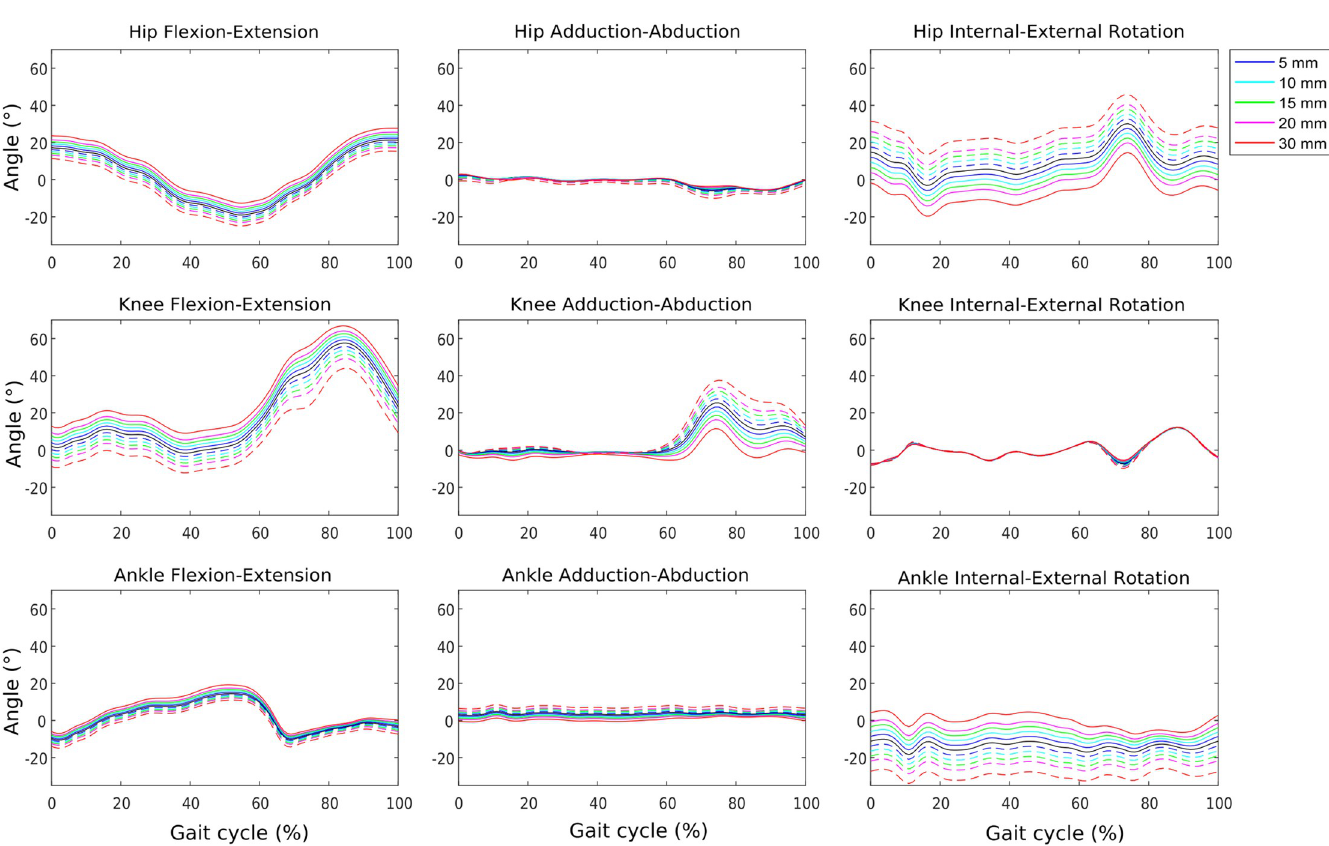
Fig 3. KNE marker misplacement on anterior-posterior direction. Kinematic deviations resultant from KNE marker misplacement on the anterior (solid lines) and posterior (dashed) directions at different magnitudes for one participant. One gait cycle is represented per condition.